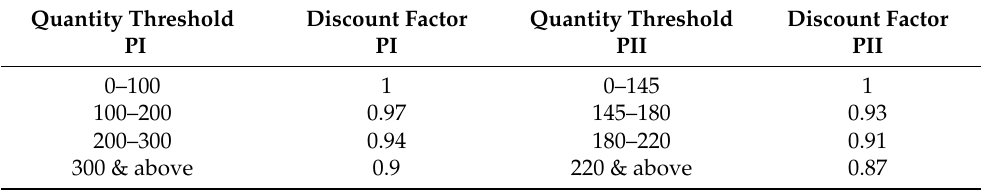
Table A8. Quantity threshold and discount factor for PI and PII for all periods.